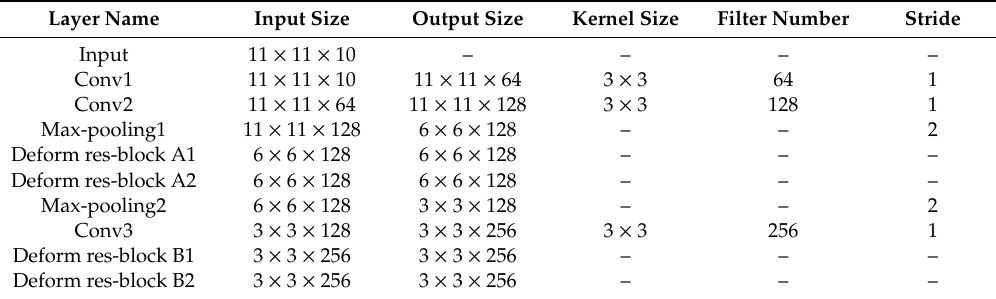
Figure 4. Architecture of the proposed single-branch CNN. Table 3. Detailed information of the single-branch CNN.